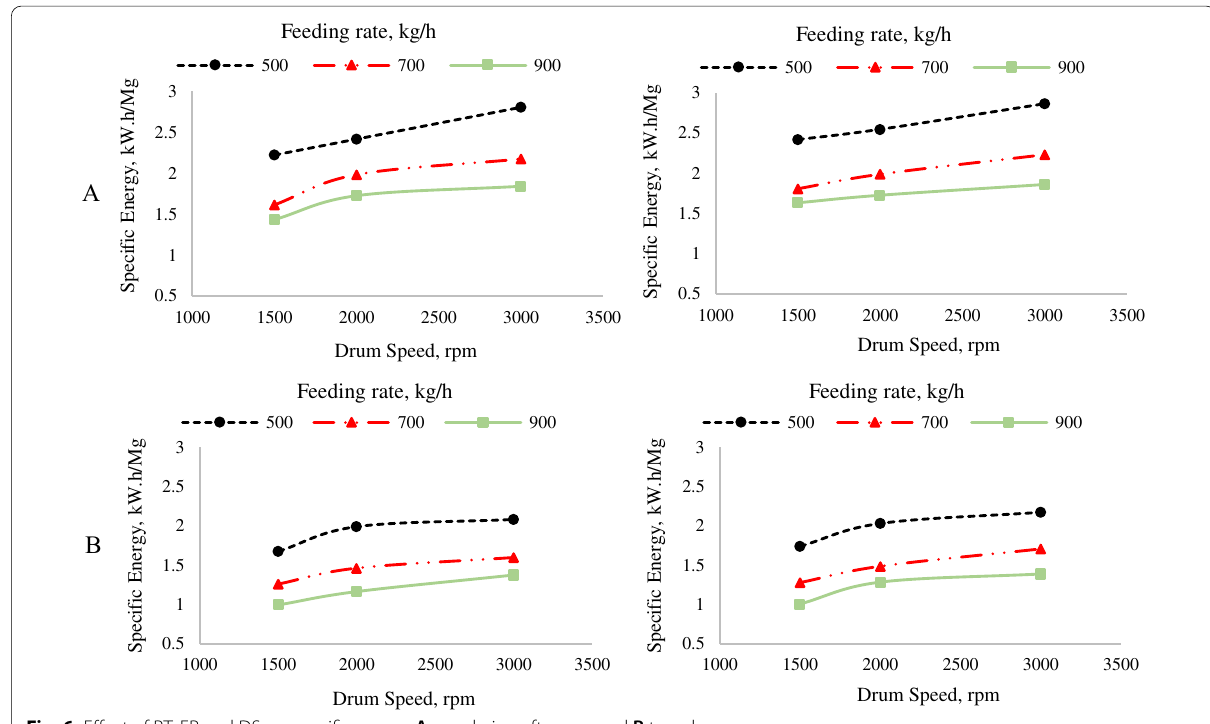
Fig. 6 Effect of RT, FR and DS on specific energy A sun drying after one and B two